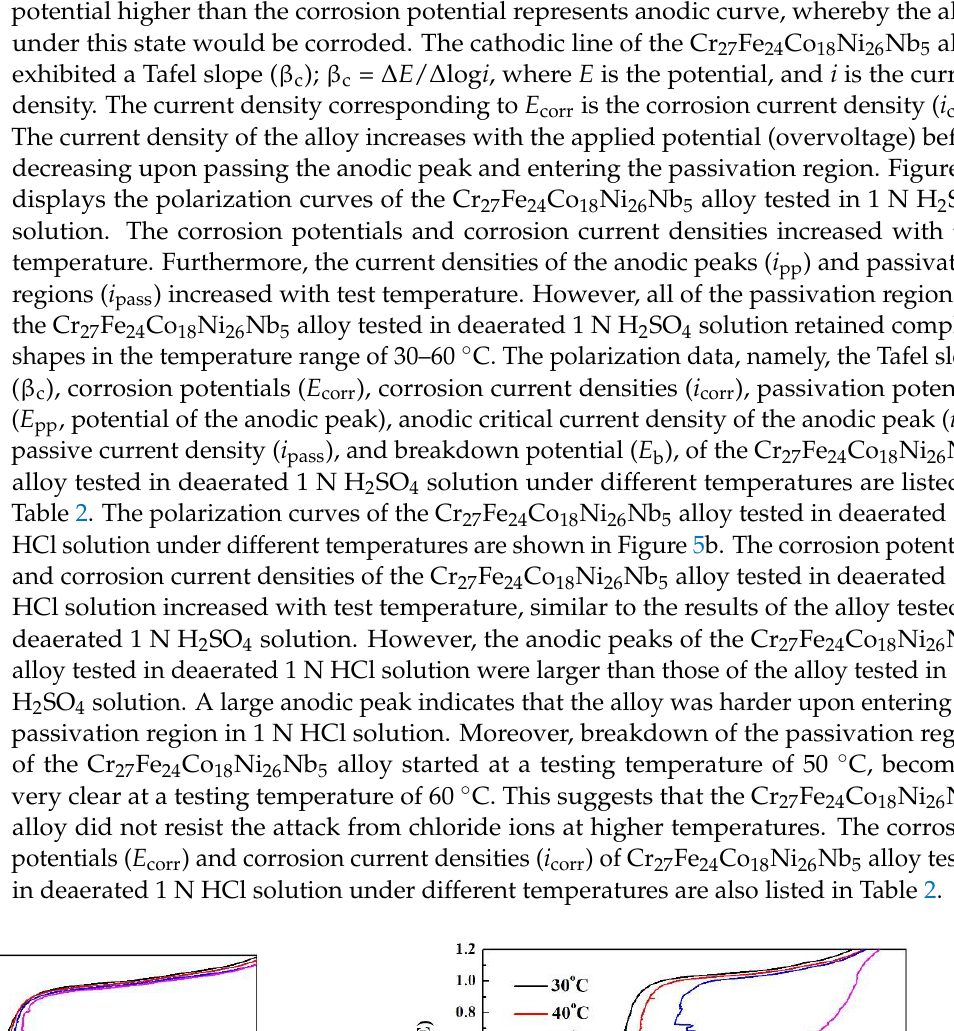
Table 2. The polarization curves of the Cr 27 Fe 24 Co 18 Ni 26 Nb 5 alloy tested in deaerated 1 N